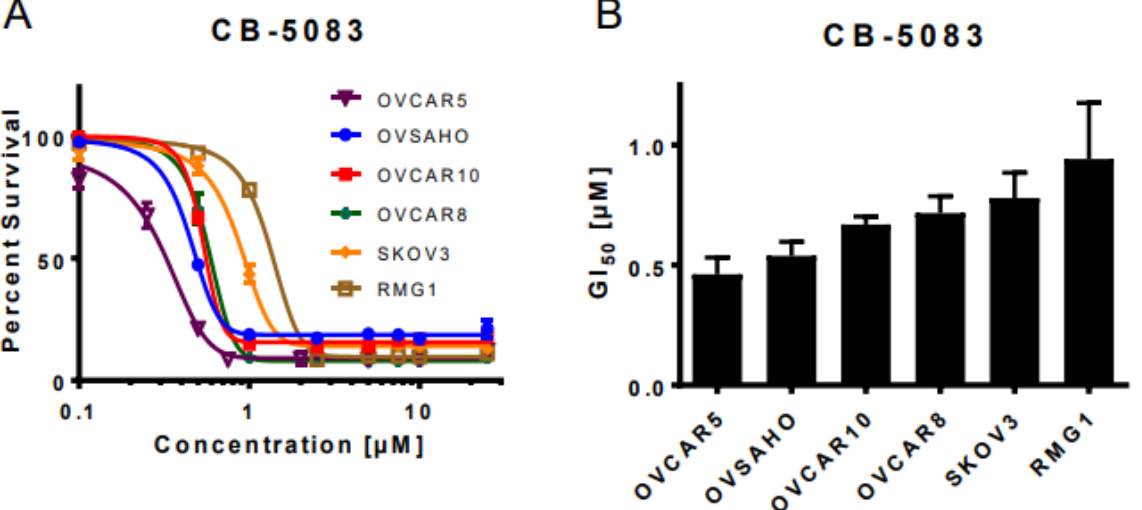
Figure 1. CB-5083 treatment is cytotoxic in ovarian cancer cell lines. ( A ): Ovarian cancer cell lines, namely OVCAR5, OVSAHO, OVCAR10, OVCAR8, SKOV3, and RMG1 were treated with increasing doses of CB-5083 ranging from 0.1 µ M to 25 µ M for 72 h. Dose–response curves were generated using GraphPad Prism based on the four parameters of nonlinear regression. The curves were constrained at the top (100%) and the bottom (>0%). Every point in the dose–response curve represents mean ± SEM taken from three technical replicates for all cell lines. ( B ): The bar graph represents mean GI 50 + SEM taken from four biological replicates in all cell lines.